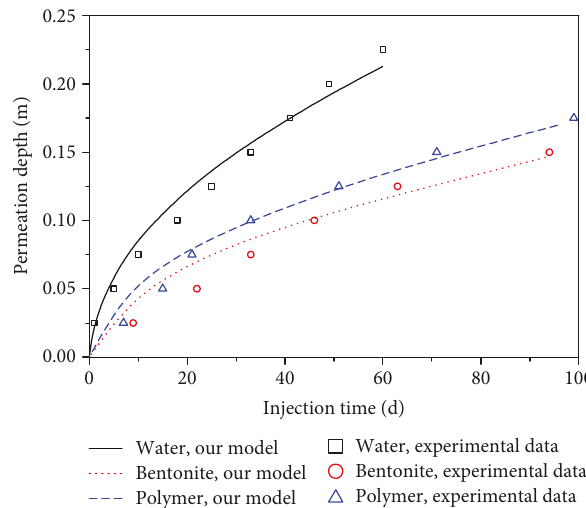
Figure 5: Comparison of the numerical results by our model with the experimental data by Al-Maamori et al.